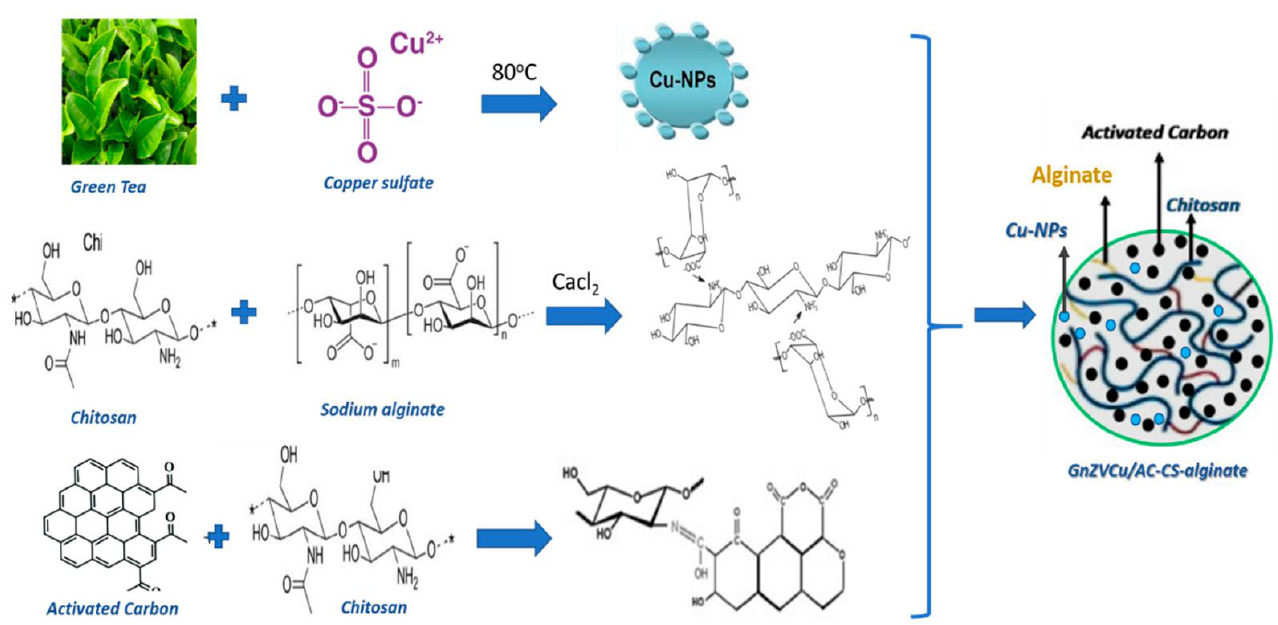
Figure 9. Schematic representation of synthesis mechanism and final structure of chitosan-alginate- based nanocomposite developed by Ahmed et al. [143]. Reprinted from an open-access source.